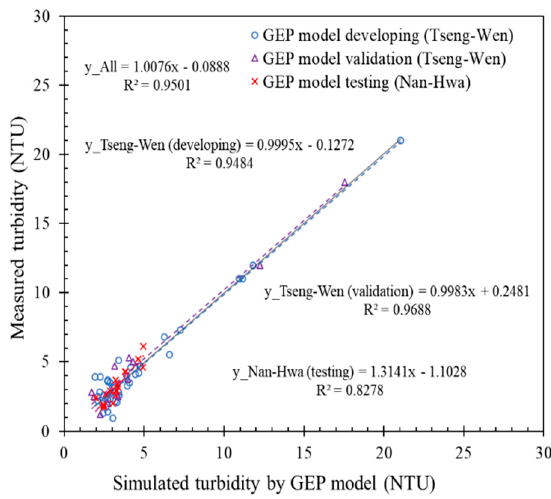
Figure 13. The correlation relationship of observed turbidity and the turbidity simulated by the gene-expression programming (GEP) model in Tseng-Wen and Nan-Hwa reservoir.